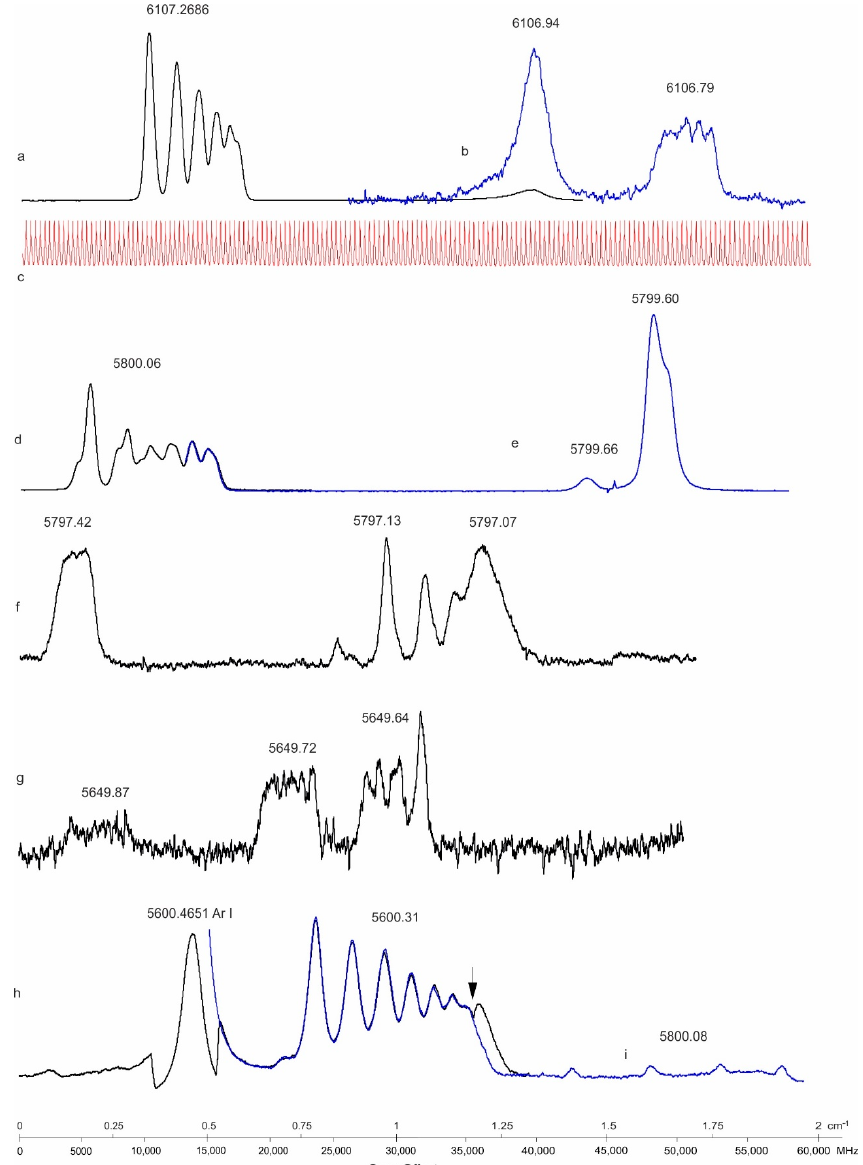
Figure 4. Examples of optogalvanic (OG) scans. Start wavelengths: (a) 6107.43Å, (b) 6107.12 Å (blue), (d) 5800.14 Å, (e) 5800.02 Å (blue), (f) 5797.45 Å, (g) 5649.92 Å, (h) 5600.60 Å, (i) 5600.45 Å (blue). Trace (c) shows the transmission signal of a marker etalon (free spectral range 367.3 MHz). Description of the lines can be found in Table 1. Wavelengths given in this graph with two figures after decimal point are readings of our lambdameter (accuracy ± 0.01 Å).